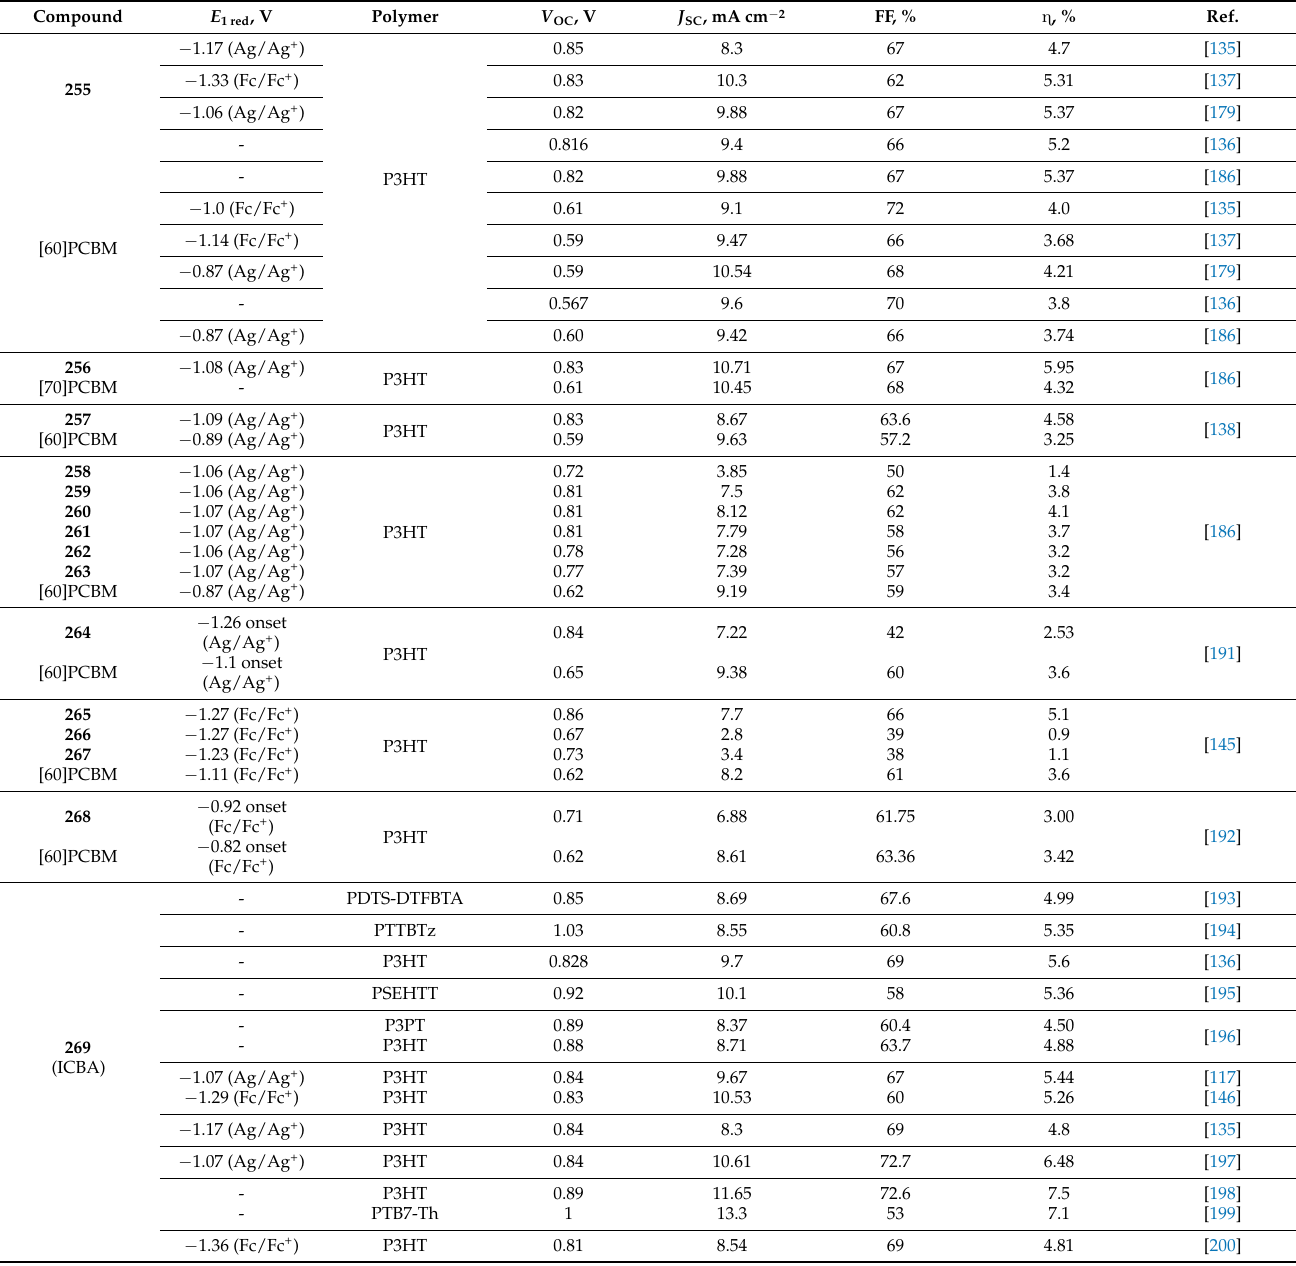
Table 9. First reduction potentials and the characteristics of solar cells based on the bis(cyclohexene) fullerenes